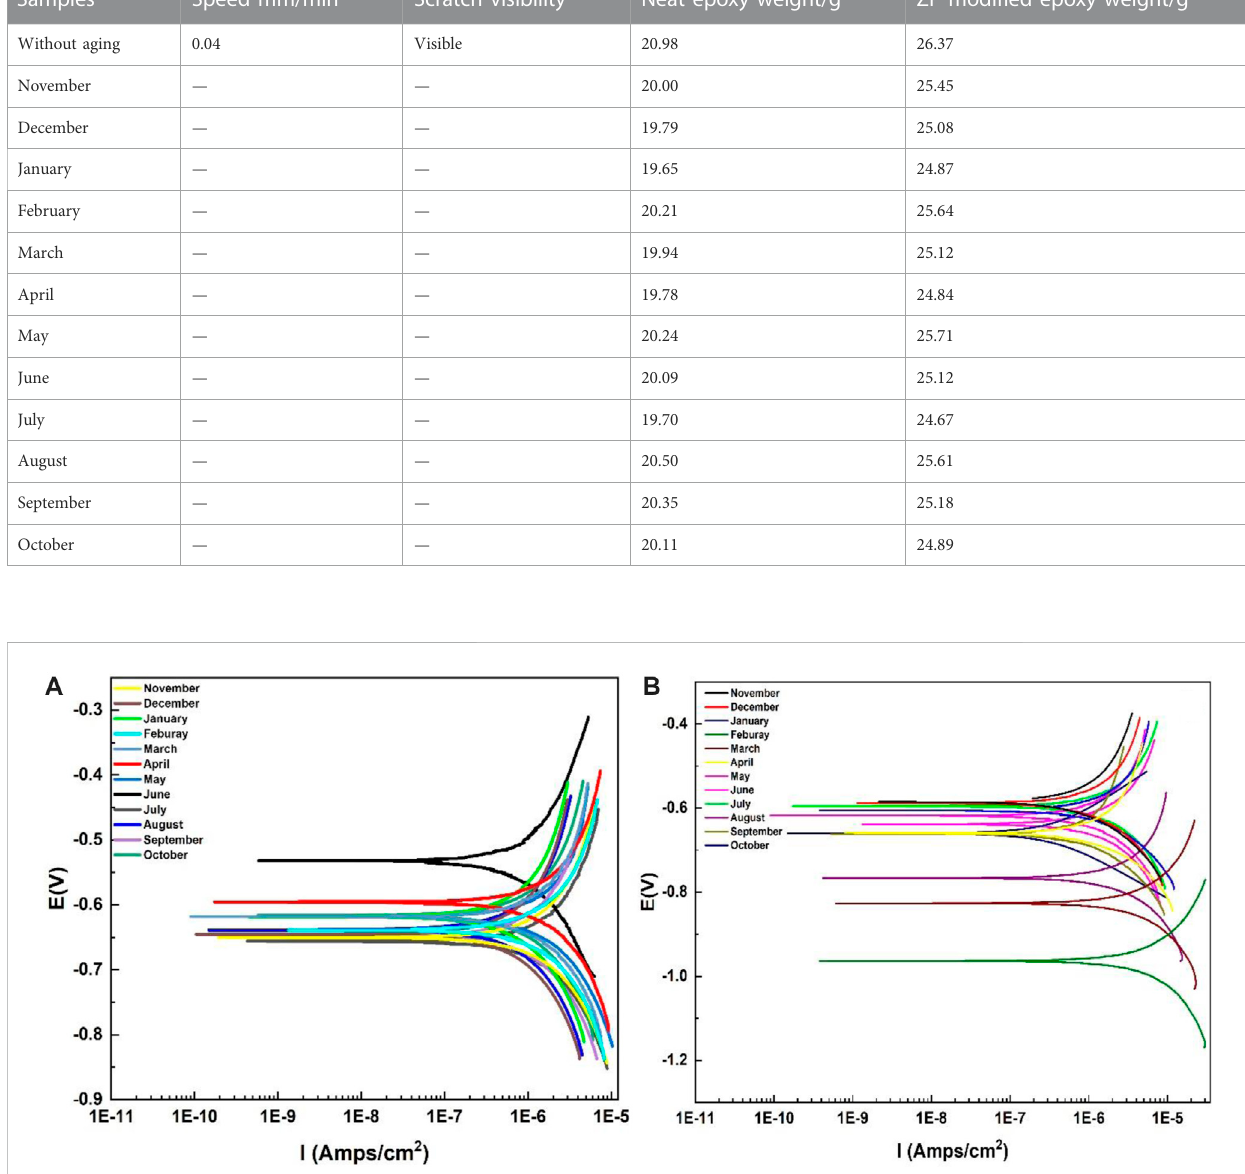
TABLE 3 Comparison of critical load on coated Al alloy 6101 for ZP modi fi ed and neat epoxy aging. Samples